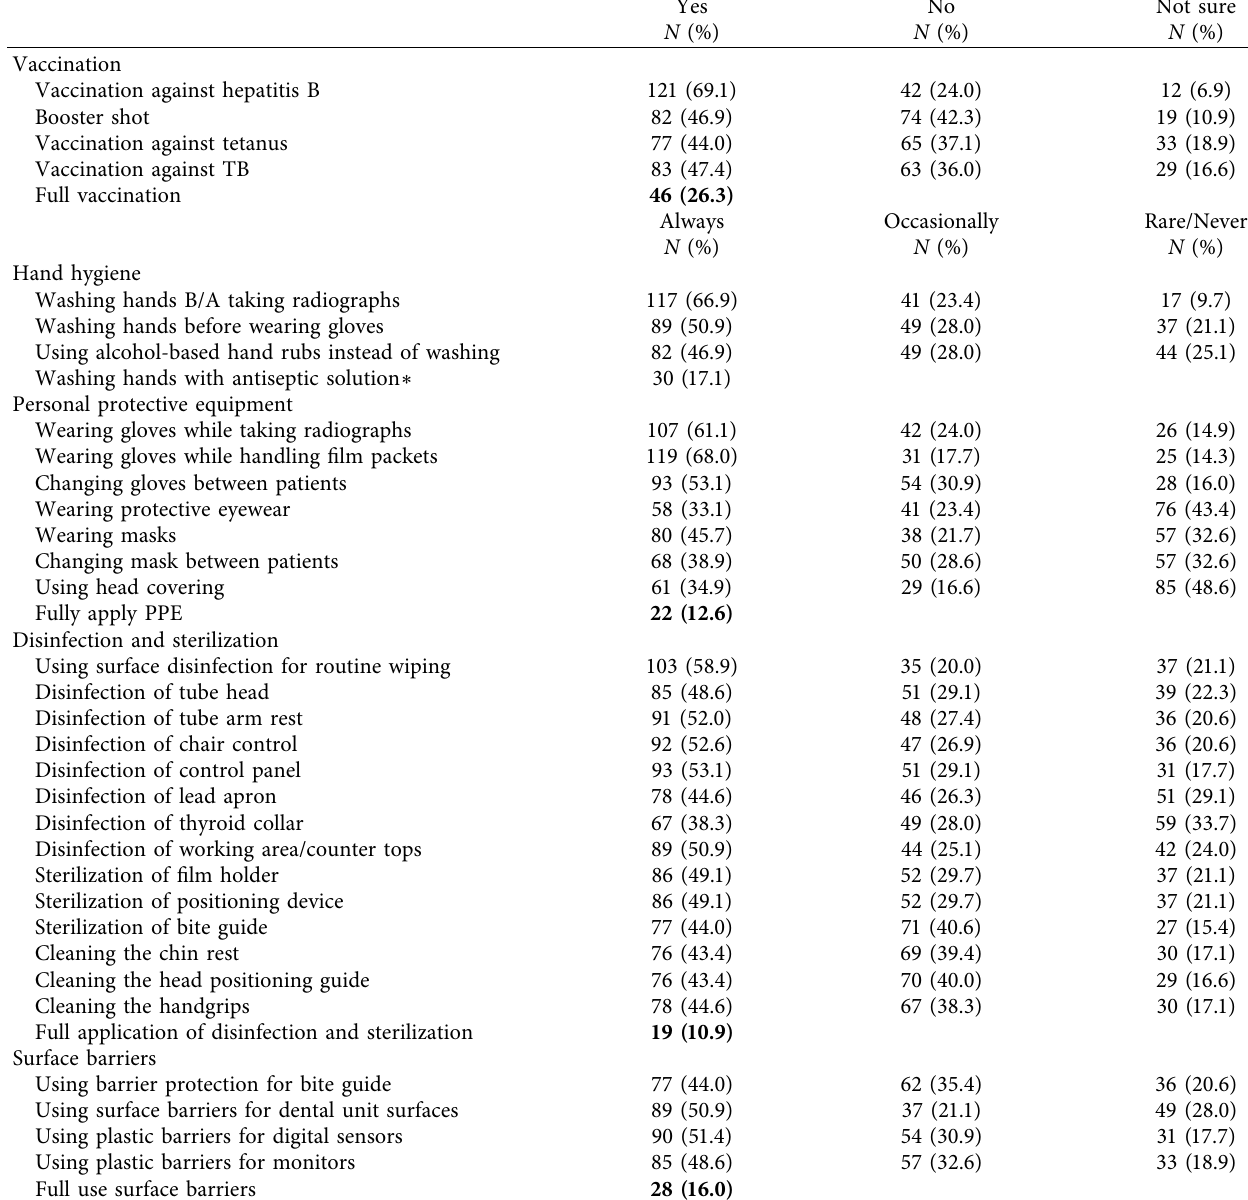
Table 2: Radiographers’ practice regarding infection control measures ( N �